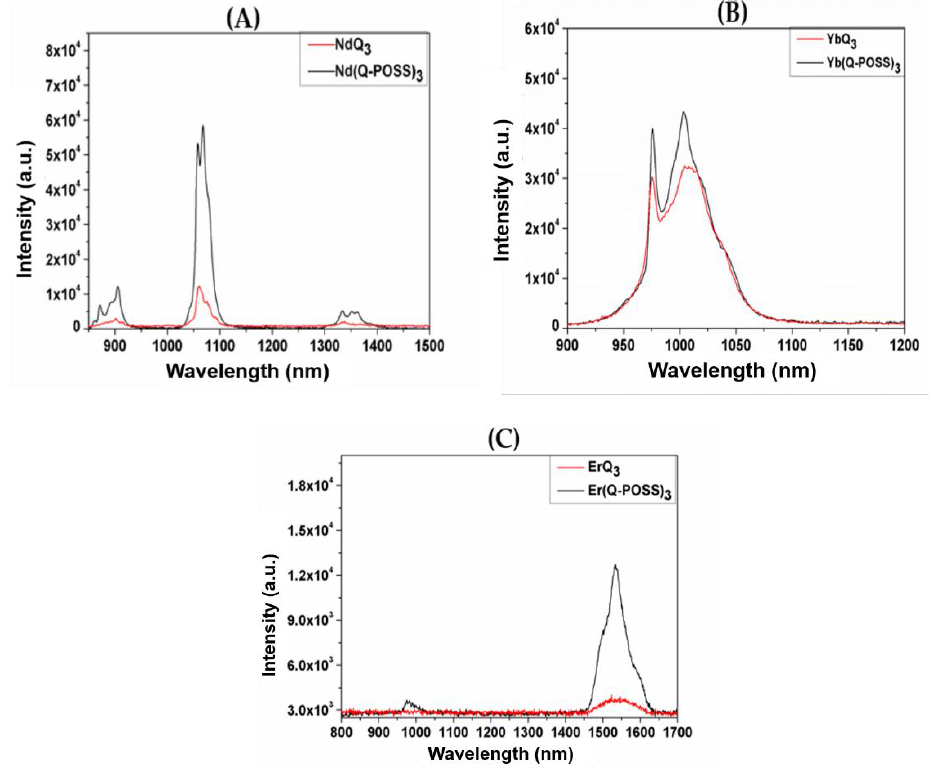
Figure 4. Emission spectra of the Ln(Q-POSS) 3 /LnQ 3 couples. ( A ) Nd(Q-POSS) 3 and NdQ 3 ( λ ex = 469 nm), ( B ) Yb(Q-POSS) 3 and YbQ 3 ( λ ex = 469 nm), and ( C ) Er(Q-POSS) 3 and ErQ 3 (λ ex = 471 nm).